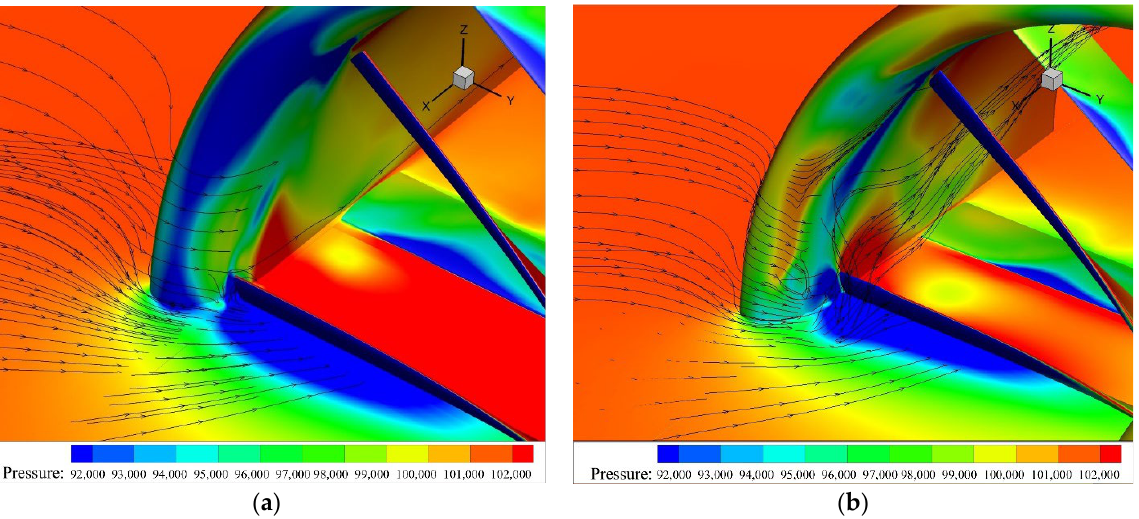
Figure 12. Static pressure distribution of the flow field near the ducted fan lip. ( a ) Axial position at 0.08 L; ( b ) axial position at 0.2 L.